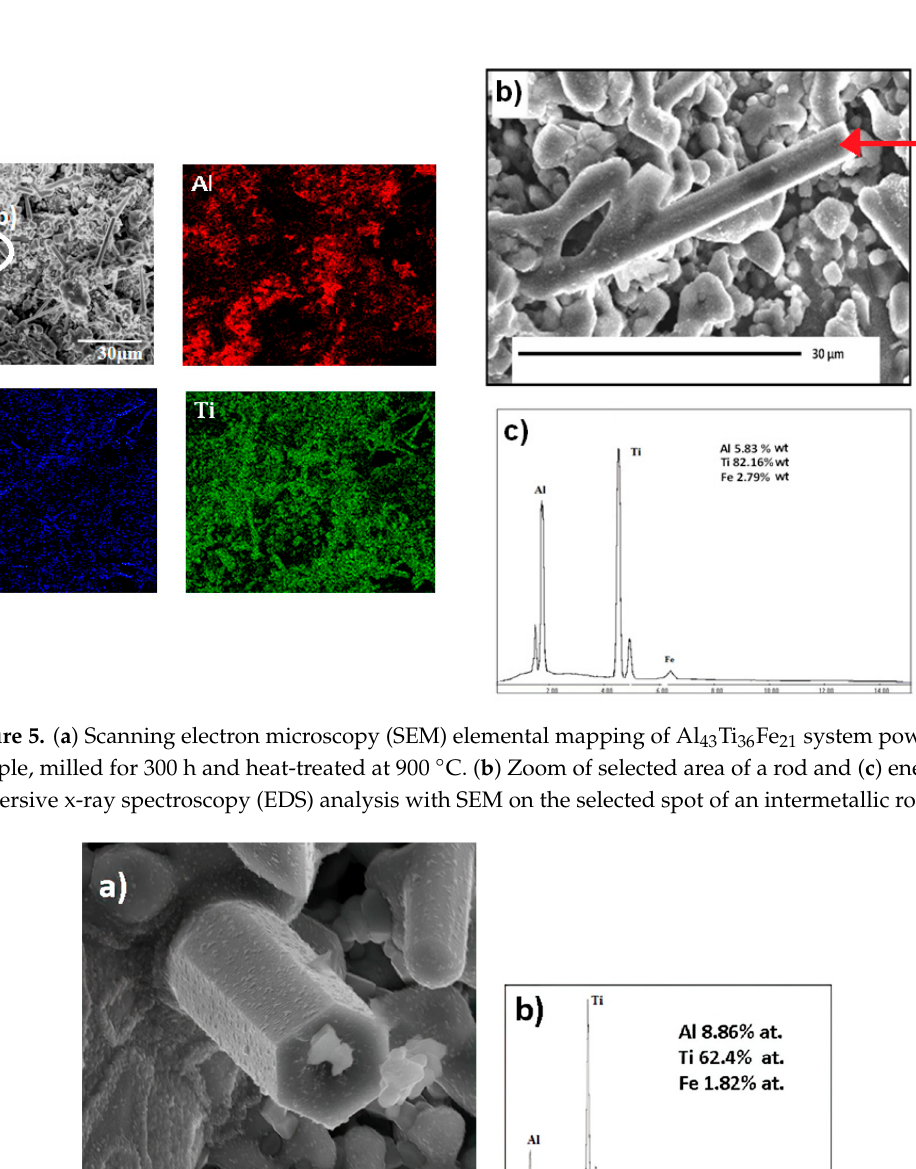
Figure 6 . ( a ) SEM micrograph and ( b ) EDS analysis of an intermetallic rod formed from mechanosynthesis and heat treatment of the Al 50 Ti 30 Fe 20 system.